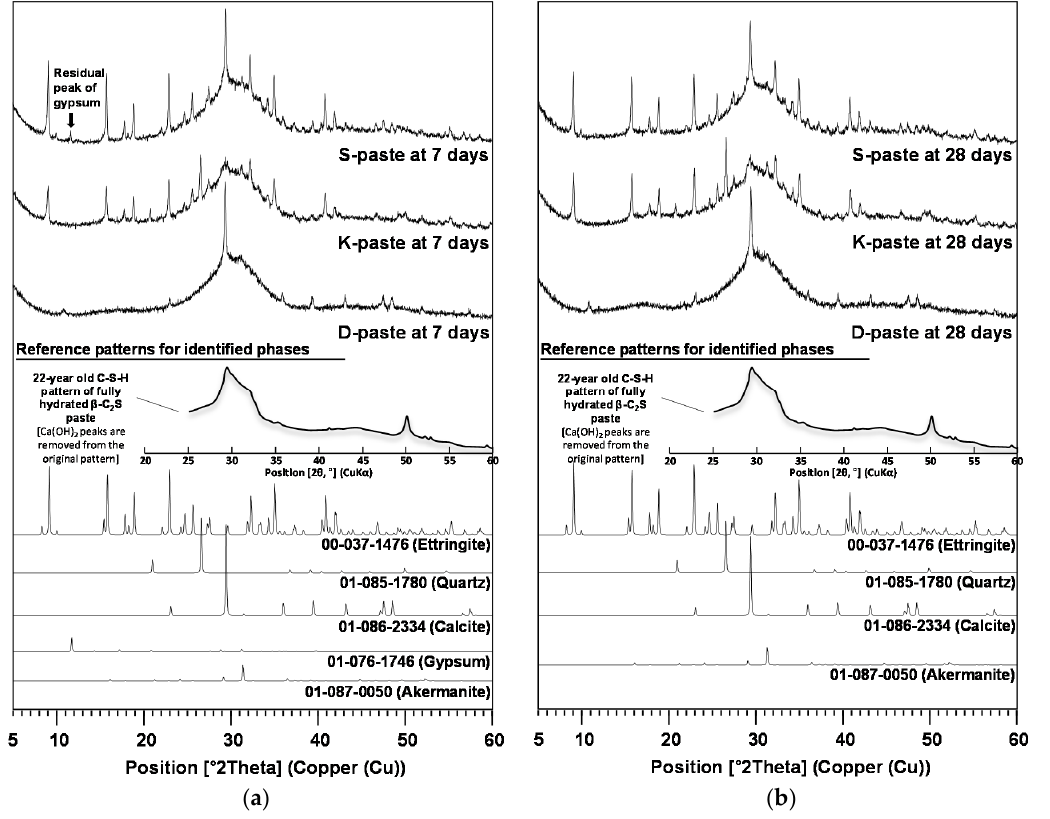
Figure 4. XRD patterns and identified phases for hardened pastes at ( a ) 7; and ( b ) 28 days.